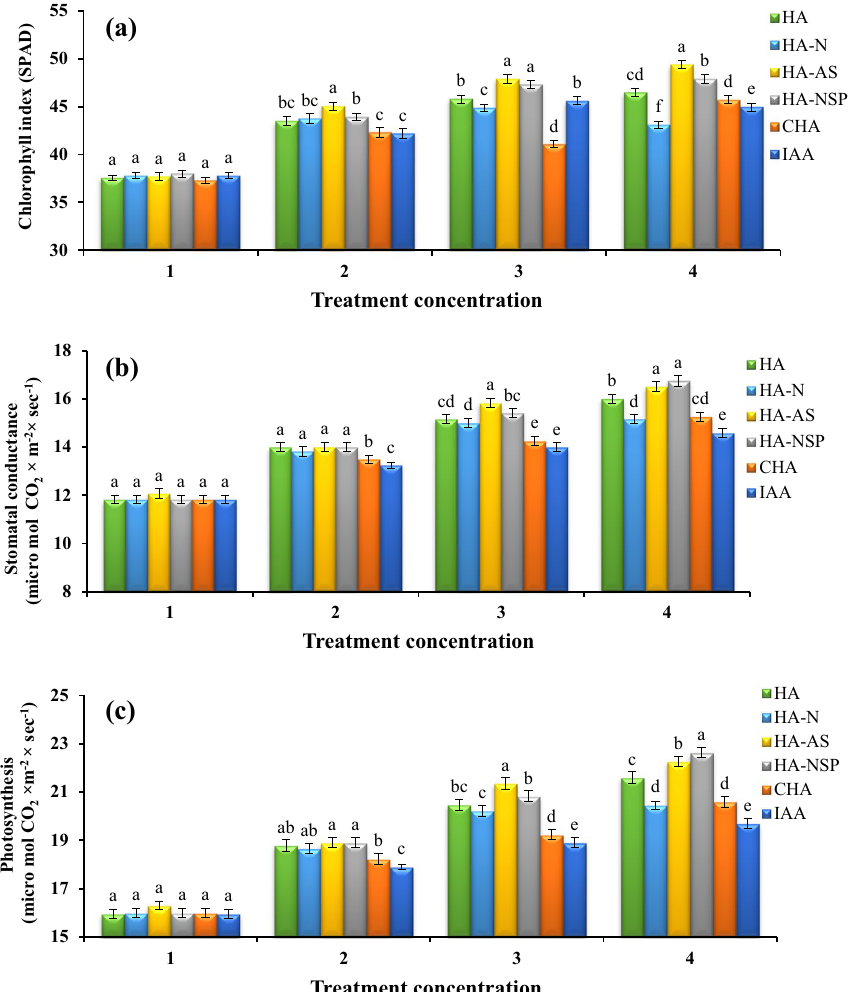
Figure 2. Comparison of average foliar application of experimental treatments on chlorophyll index (SPAD) ( a ), stomatal conductance ( b ), and photosynthesis ( c ) at treatment concentrations (levels 1, 2, 3 and 4 for HA, HA-N, HA-AS, HA-NSP and CHA treatments of 0, 200, 400 and 600 mg L −1 and 0, 10 –6 , 10 –5 and 10 –4 molar IAA). Different letters in each figure show significant difference at p ≤ 0.05 by Duncan multiple range test. HA, HA extracted from vermicompost without enrichment; HA-N, HA extracted from vermicompost enriched with 1% nitrogen; HA-NSP, HA extracted from vermicompost enriched with 1% nitrogen, 1% sulfur, and 1% phosphorus; HA-AS, HA extracted from vermicompost enriched with Azotobacter